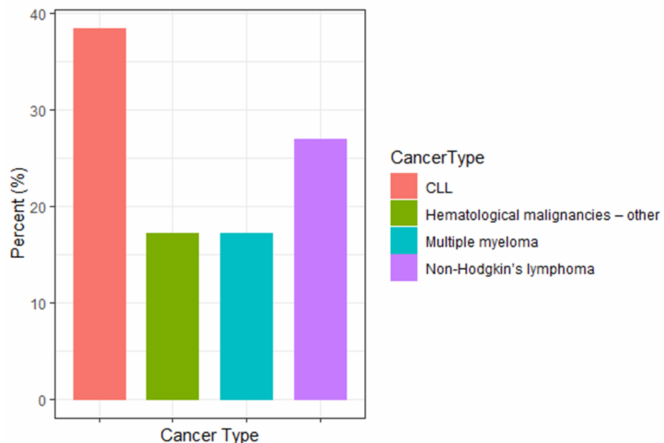
Figure 2. Cancer Type distribution. Cancer types were categorized into major cancer groups. The main groups included CLL (37.9%), non-Hodgkin’s lymphoma (27.4%), and multiple myeloma (16.9%). Hematological malignancies-other (17.2%) included: myelofibrosis (1.6%), acute lymphocytic leukemia (3.3%), acute myeloid leukemia (4.9%), chronic myeloid leukemia (0.8%), and Hodgkin’s lymphoma (4.1%) and unspecified lymphoma (2.5%).